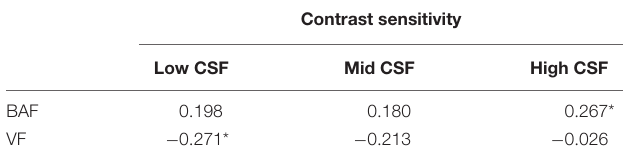
TABLE 2 | Correlation coefficients (r) between binocular accommodative facility (BAF)/vergence facility (VF) and contrast sensitivity (Low CSF, Mid CSF, High SF) in 104